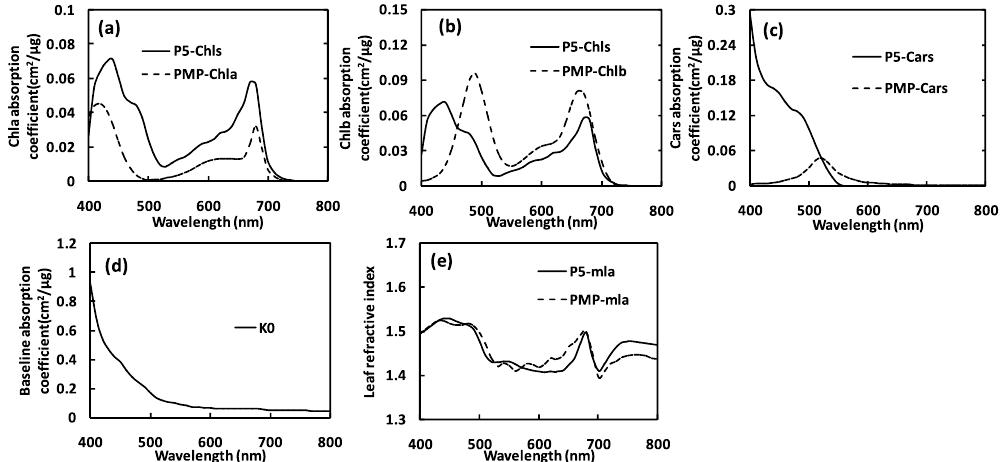
); ( b ) for Chlb absorption Chla ); and ( e ) for leaf average refractive 0